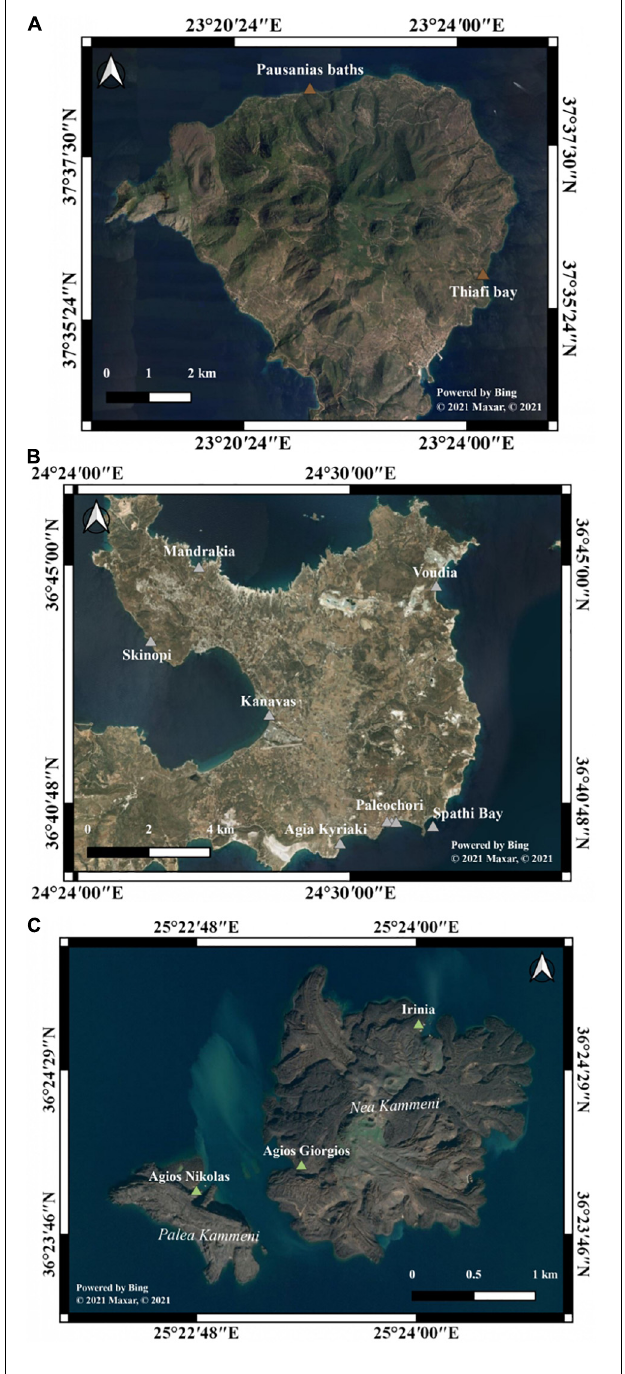
FIGURE 3 | (A) Map of the Methana Peninsula that shows the locations and names of the emission points. (B) Map of the western section of Milos Island that shows the locations and names of the emission points. (C) Map of the Kammeni Islands that shows the locations and names of the emission points.